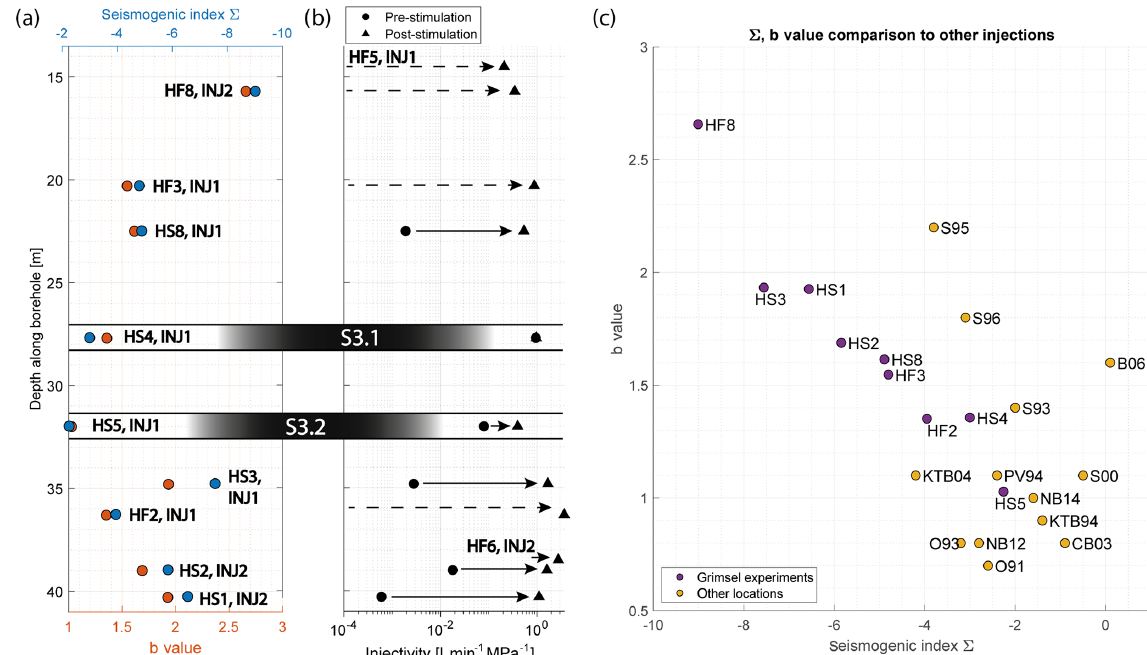
Figure 13. (a) Seismic responses (seismogenic indices, b values) along with (b) pre- and post-injectivity values of experiments along the depth of the injection boreholes. Location of S3 shear zones and experiment HS4 and HS5 therein are highlighted. Injectivity values of ex- periment HF5 and HF6 for which the number of located seismic events renders a determination of b value and seismogenic index impossible, are also included. (b) b values and seismogenic indices of various high-pressure fluid injections at different sites (source seismogenic indices and b values from other locations: Dinske and Shapiro, 2013; Shapiro et al., 2013; and Mignan et al.,